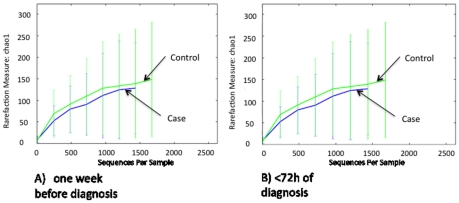
Chao rarefaction diversity.Chao diversity was calculated from sequence distribution A) one week before and B) within 72 hours of NEC diagnosis.